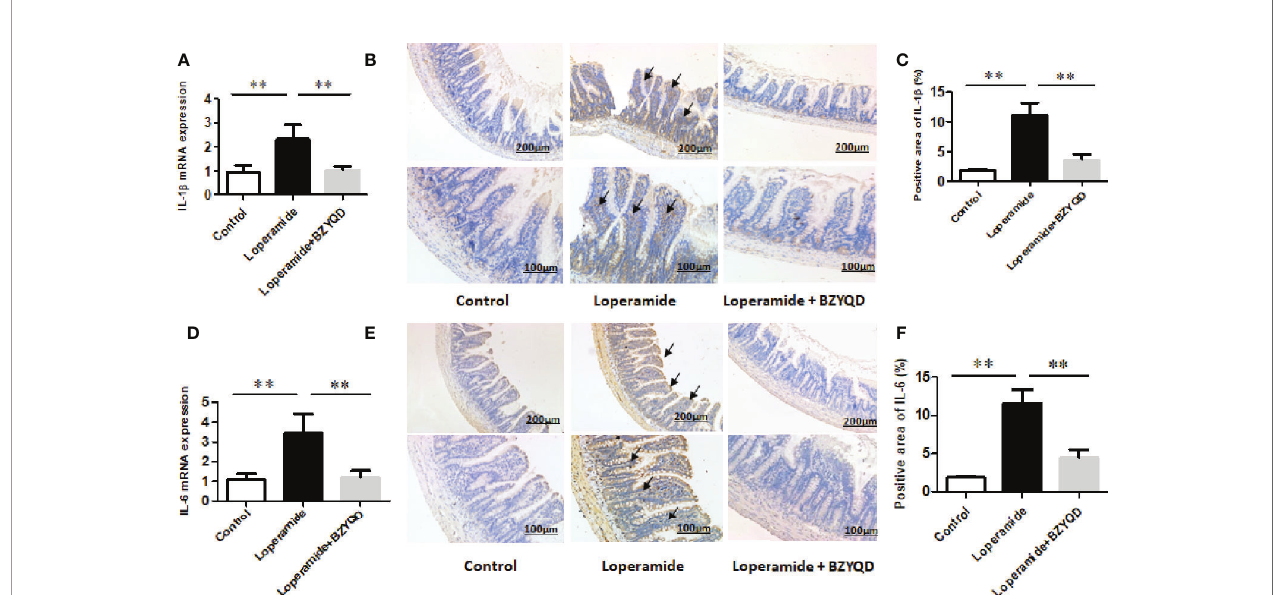
FIGURE 7 | Effect of BZYQD intervention on expression of colon in fl ammatory factors in loperamide-treated rats. BZYQD decreased the mRNA and protein expression of IL-1 b and IL-6: (A) The mRNA expression of IL-1 b of colon tissues that detected by real-time PCR; (B) Protein expression of IL-1 b of colon tissues that detected using immunohistochemistry; (C) Quanti fi cation of protein expression of IL-1 b of colon tissues. (D) The mRNA expression of IL-6 of colon tissues that detected by real-time PCR; (E) Protein expression of IL-6 of colon tissues that detected using immunohistochemistry; (F) Quanti fi cation of protein expression of 6 of colon tissues. Data are represented as mean ± SD. Arrow marks pointed to positive area expression. (n = 5). ** P < 0.01 between